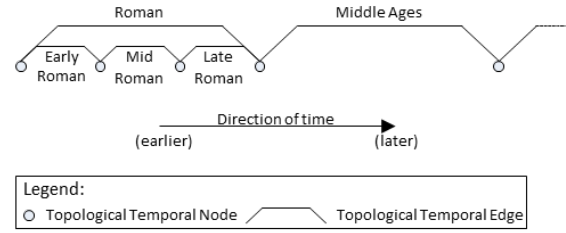
Figure 11 Topological structure of archaeological time scale after Michalak (2005)